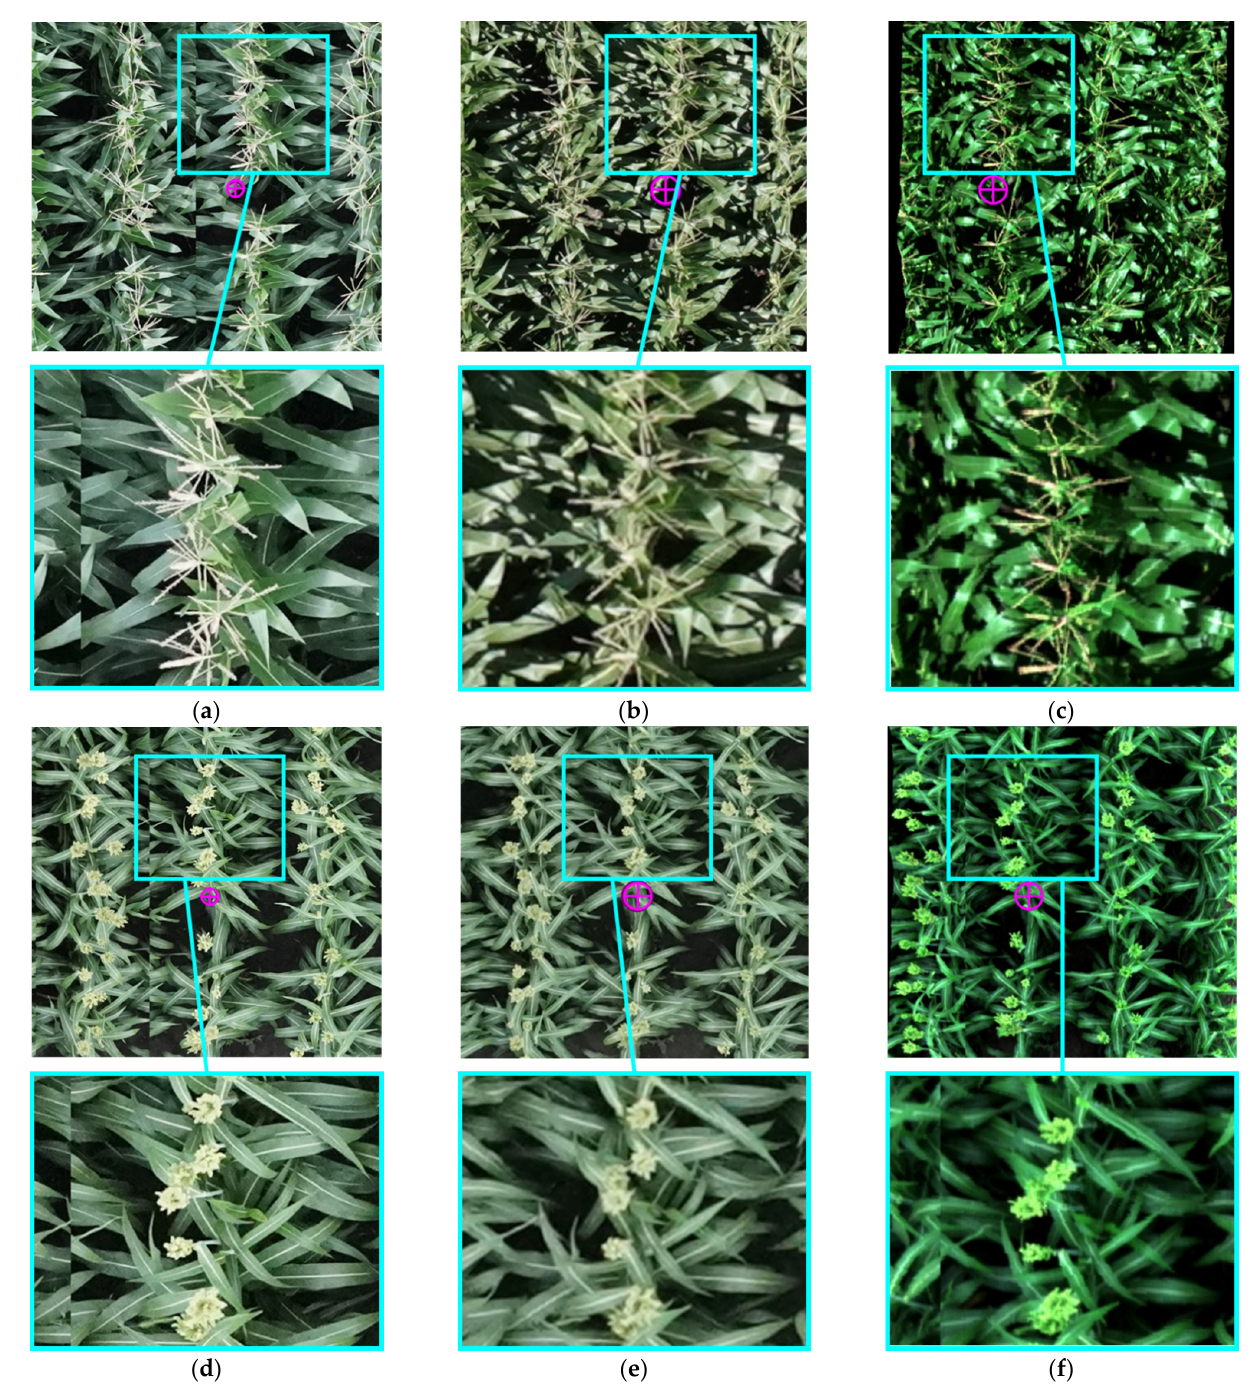
Figure 18. Generated orthophotos using different image datasets captured by UAV frame cameras and PhenoRover push- broom scanners over maize and sorghum fields: ( a ) orthophoto I, ( b ) orthophoto II, ( c ) orthophoto III, ( d ) orthophoto IV, ( e ) orthophoto V, and ( f ) orthophoto VI. The magenta circles in orthophotos I, II, and III and in orthophotos IV, V, and VI represent the same point (included for easier comparison of the visual quality of the different orthophotos).